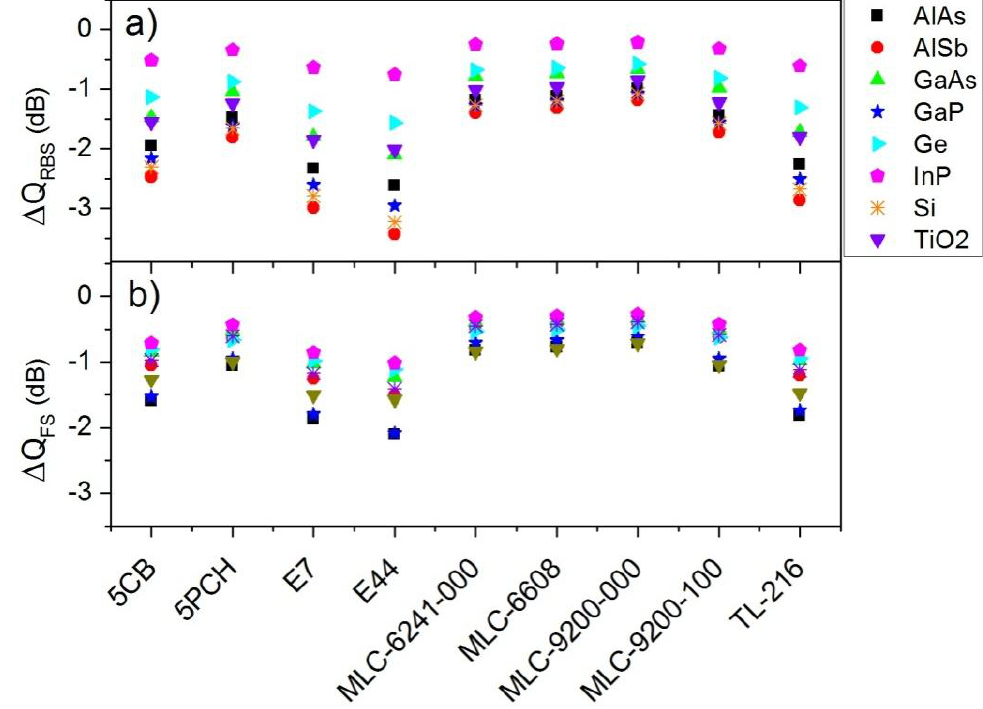
Figure 3. Variation of ( a ) the radar backscattering efficiency ( Q ) and ( b ) the forward RBS scattering efficiency, in dB, of a spherical particle of R = 100 nm embedded in a LC that changes its refractive index from the ordinary to the extraordinary value versus the surrounding LC. The incident wavelength satisfies the first and second Kerker’s conditions, respectively, when the LC presents the n . Several semiconductor materials are o